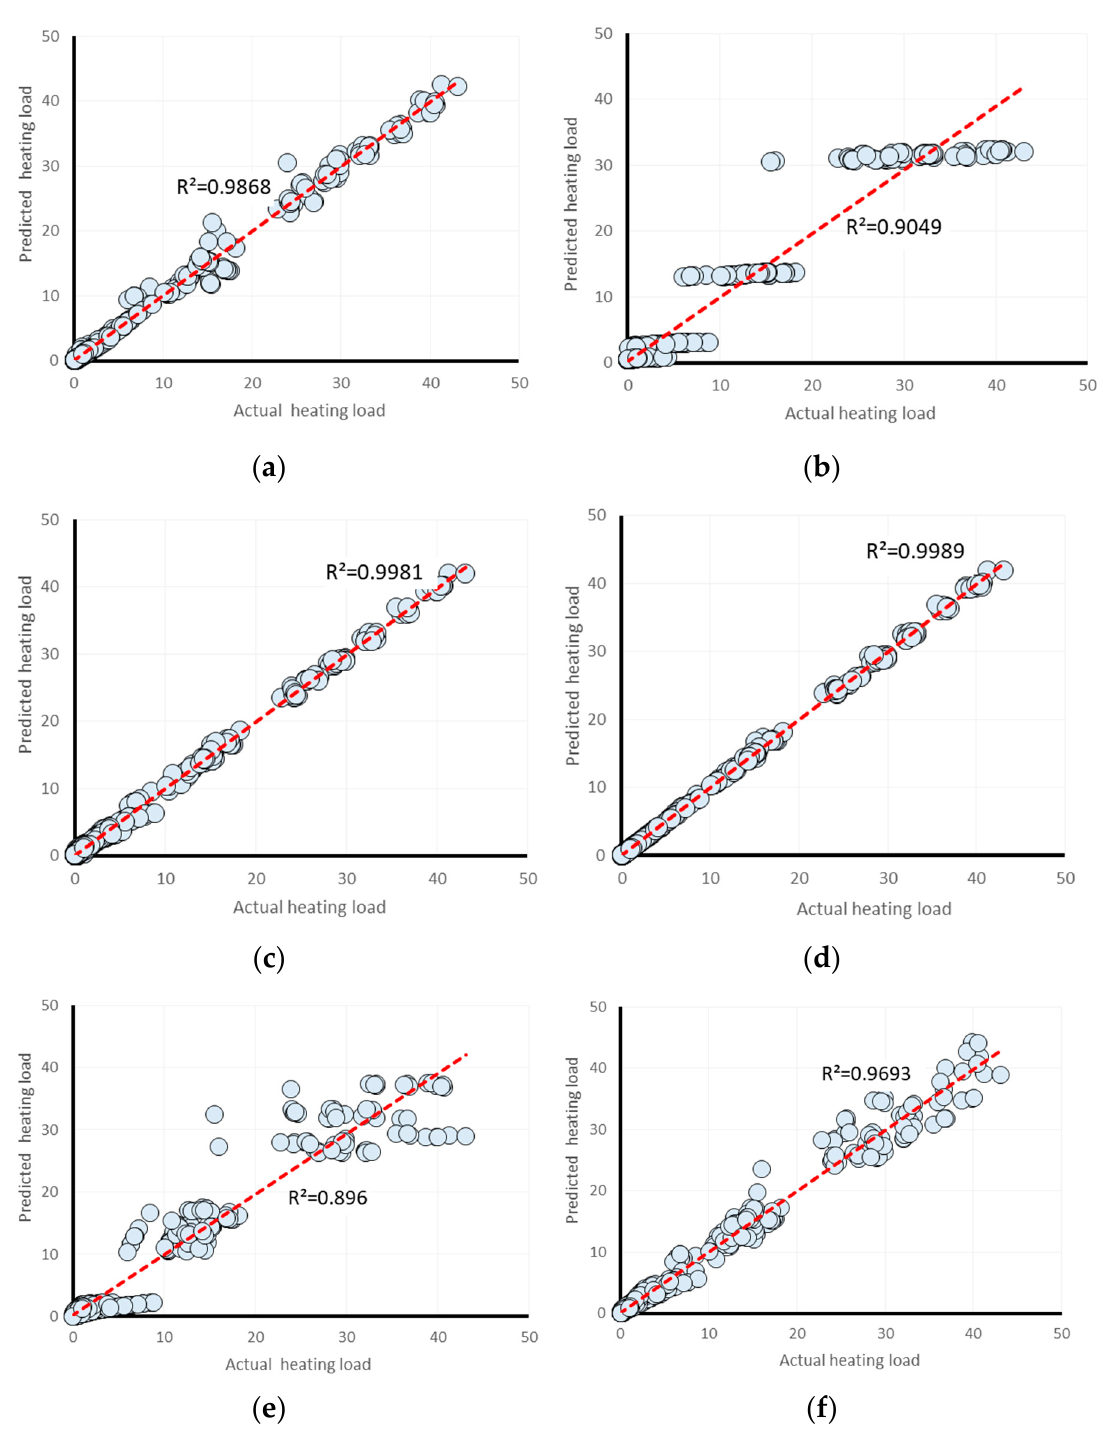
Figure 11. The network outputs for the testing dataset. ( a ) MLPr; ( b ) LLWL; ( c ) AMT; ( d ) RF; ( e ) ENet; ( f ) RBFr.